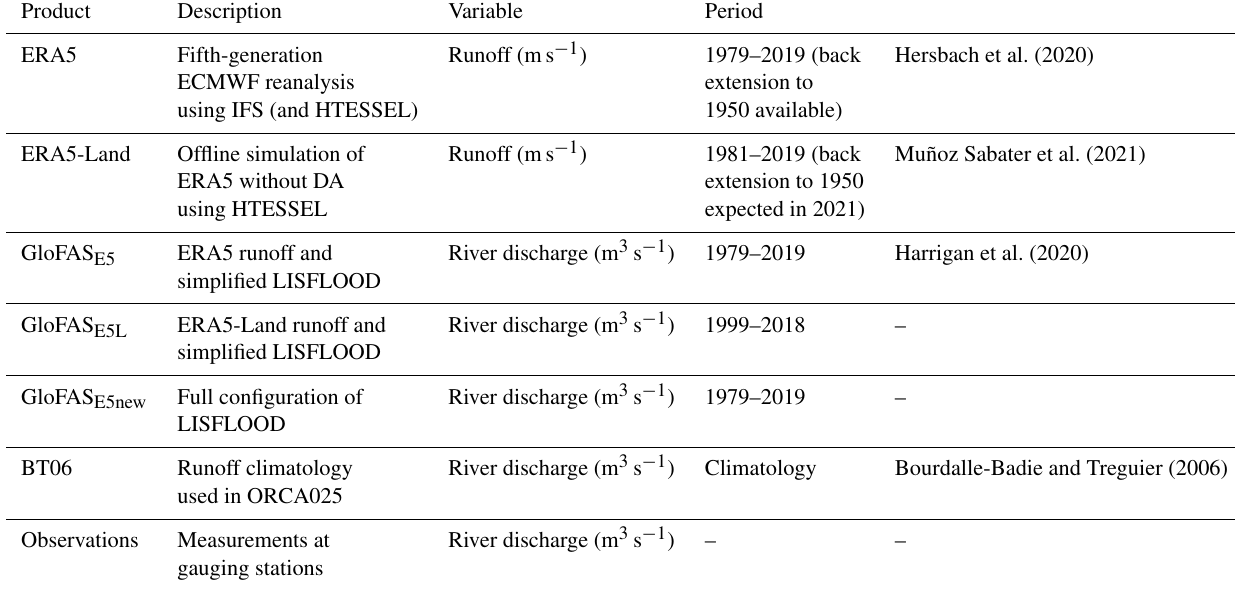
Table 2. List of all runoff and river discharge